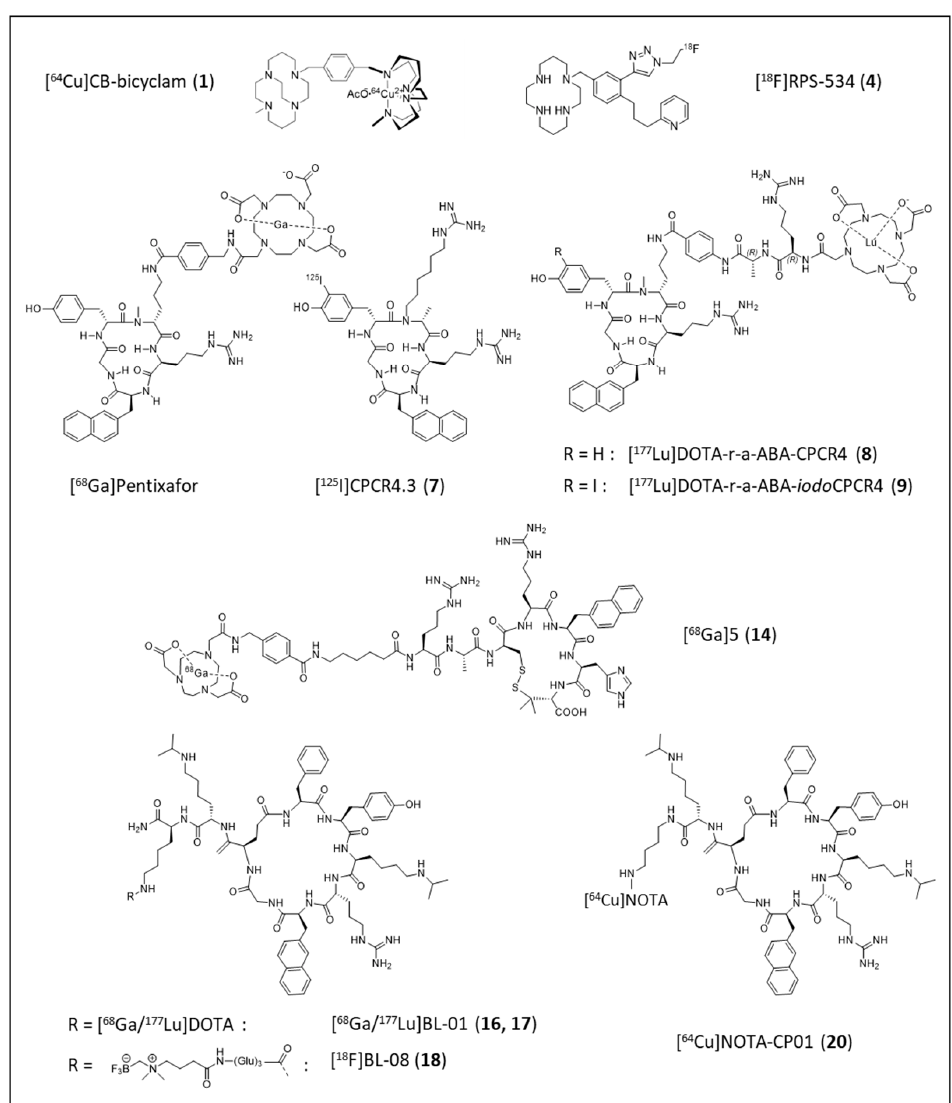
Figure 3. Chemical structures of the clinically used CXCR4 imaging agent [ 68 Ga]Pentixafor and of selected novel CXCR4-targeted tracers under preclinical evaluation. Bold numbers in parentheses represent the entry number of the respective compound in Table 1.